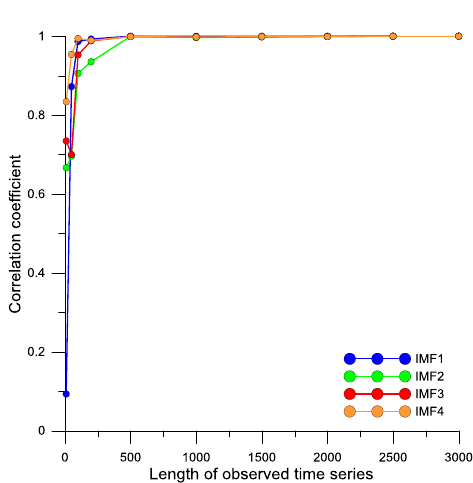
Figure 7. Correlation coefficients between IMFs obtained from the entire water demand time series and ones from the partial water demand time series with different lengths.